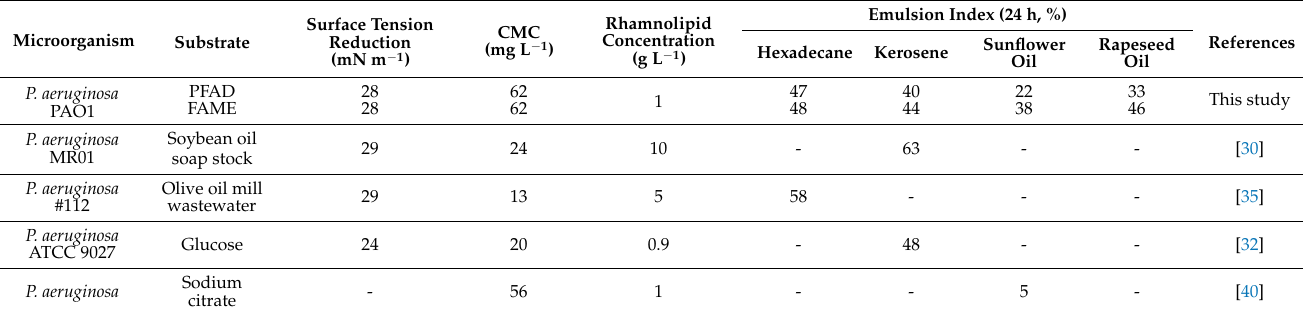
Table 3. The effect of rhamnolipid comparison produced from various sources of carbon and microorganisms. Microorganism